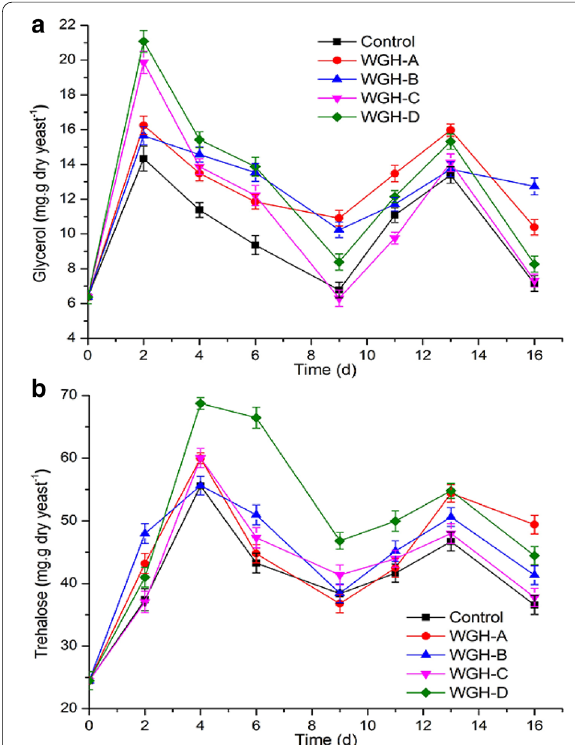
Fig. 2 Effects of WGH-A, WGH-B, WGH-C and WGH-D additions on the levels of intracellular glycerol ( a ) and trehalose ( b ) in yeast cells during the VHG fermentation. WGH-A, supernatant of wheat gluten hydrolysate; WGH-B, WGH-C and WGH-D, 0, 20 and 40% ethanol elution fractions of WGH-A on XAD-16 resin, respectively. Error bars indicate the standard deviations from three independent determinations